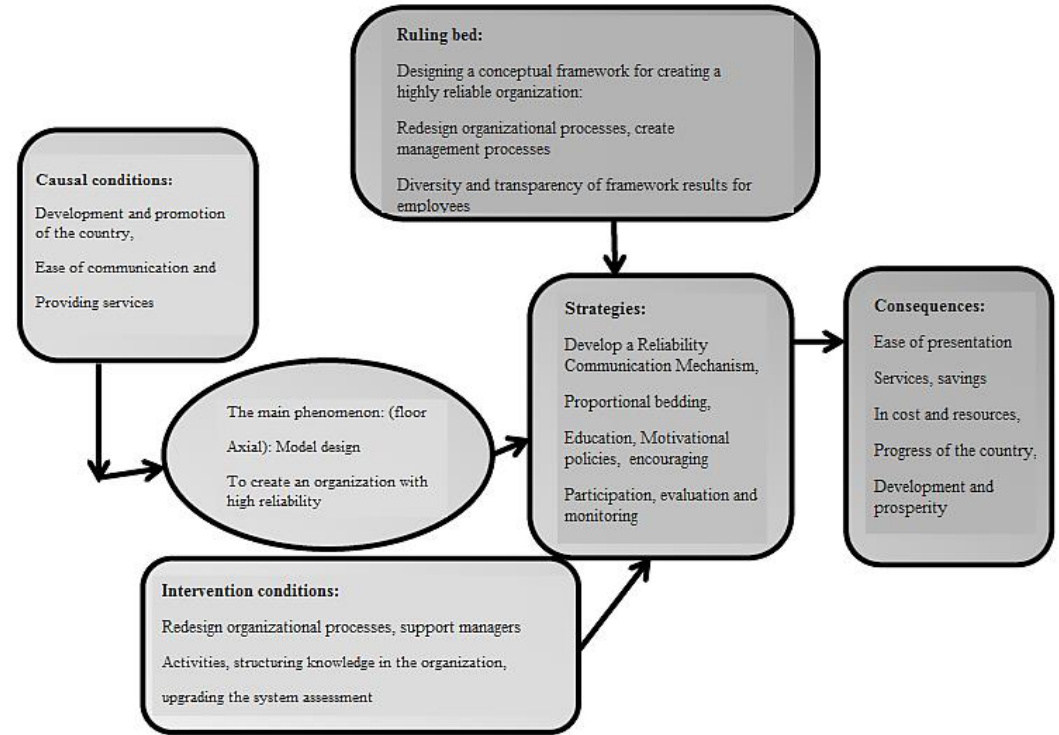
Fig. 1. Axial coding based on the paradigm